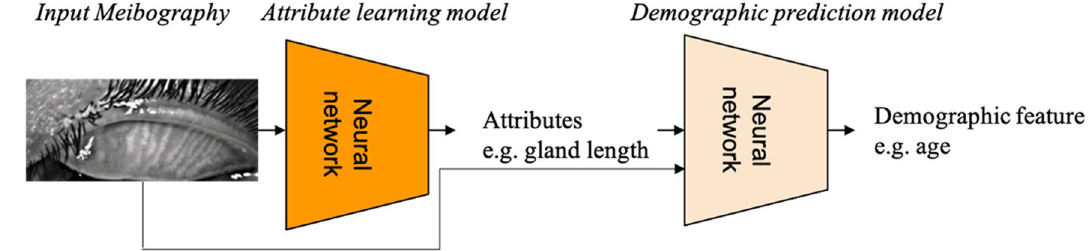
Figure 3. Overall pipeline of the interpretable deep learning model for predicting demographics from